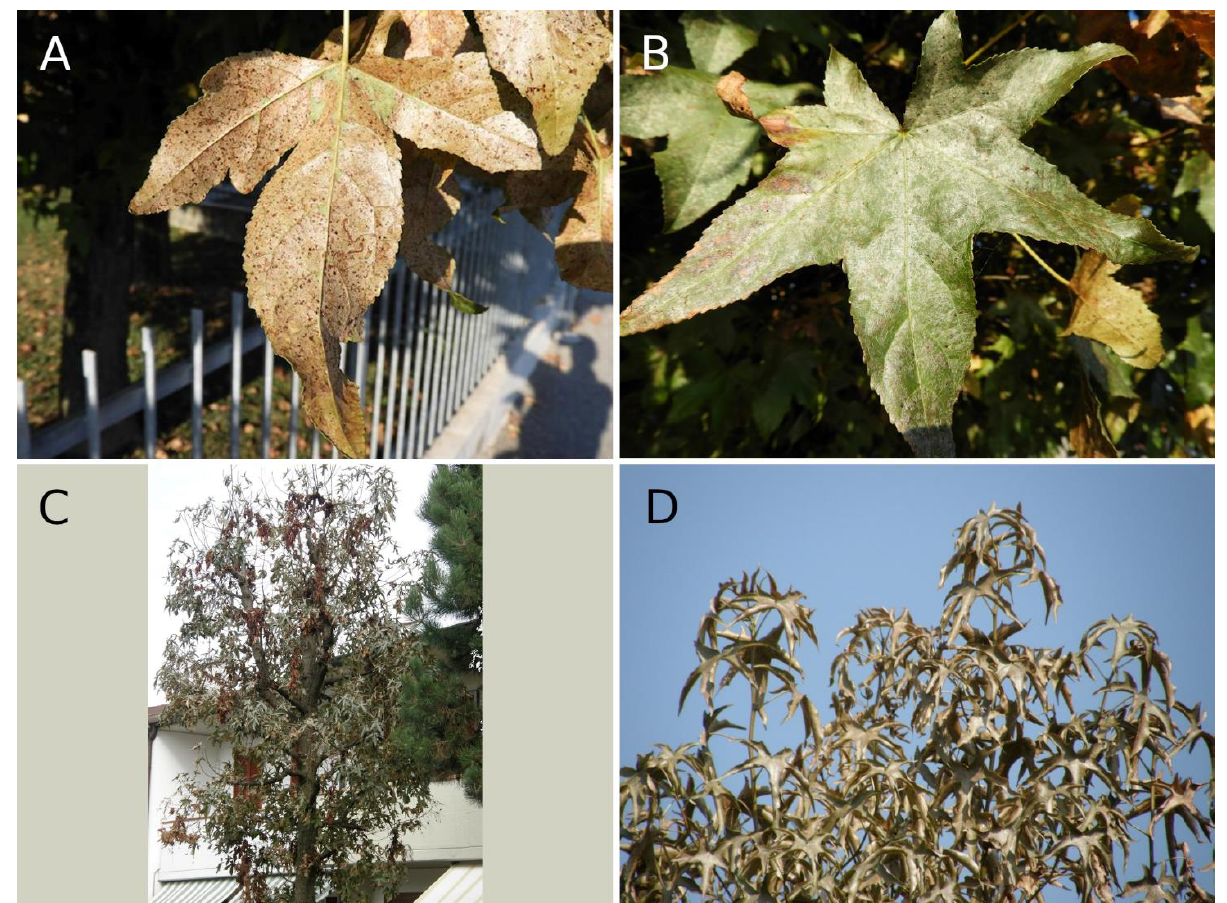
Figure A4. ( A , B ) Symptoms of S. rubrocinctus infestation on the lower and upper side of Liquidambar styraciflua leaves (Pandino, 2019); ( C , D ) effects of intense S. rubrocinctus infestation on Liquidambar styraciflua (Palazzo Pignano, 2015). Photos A. Wojnar.